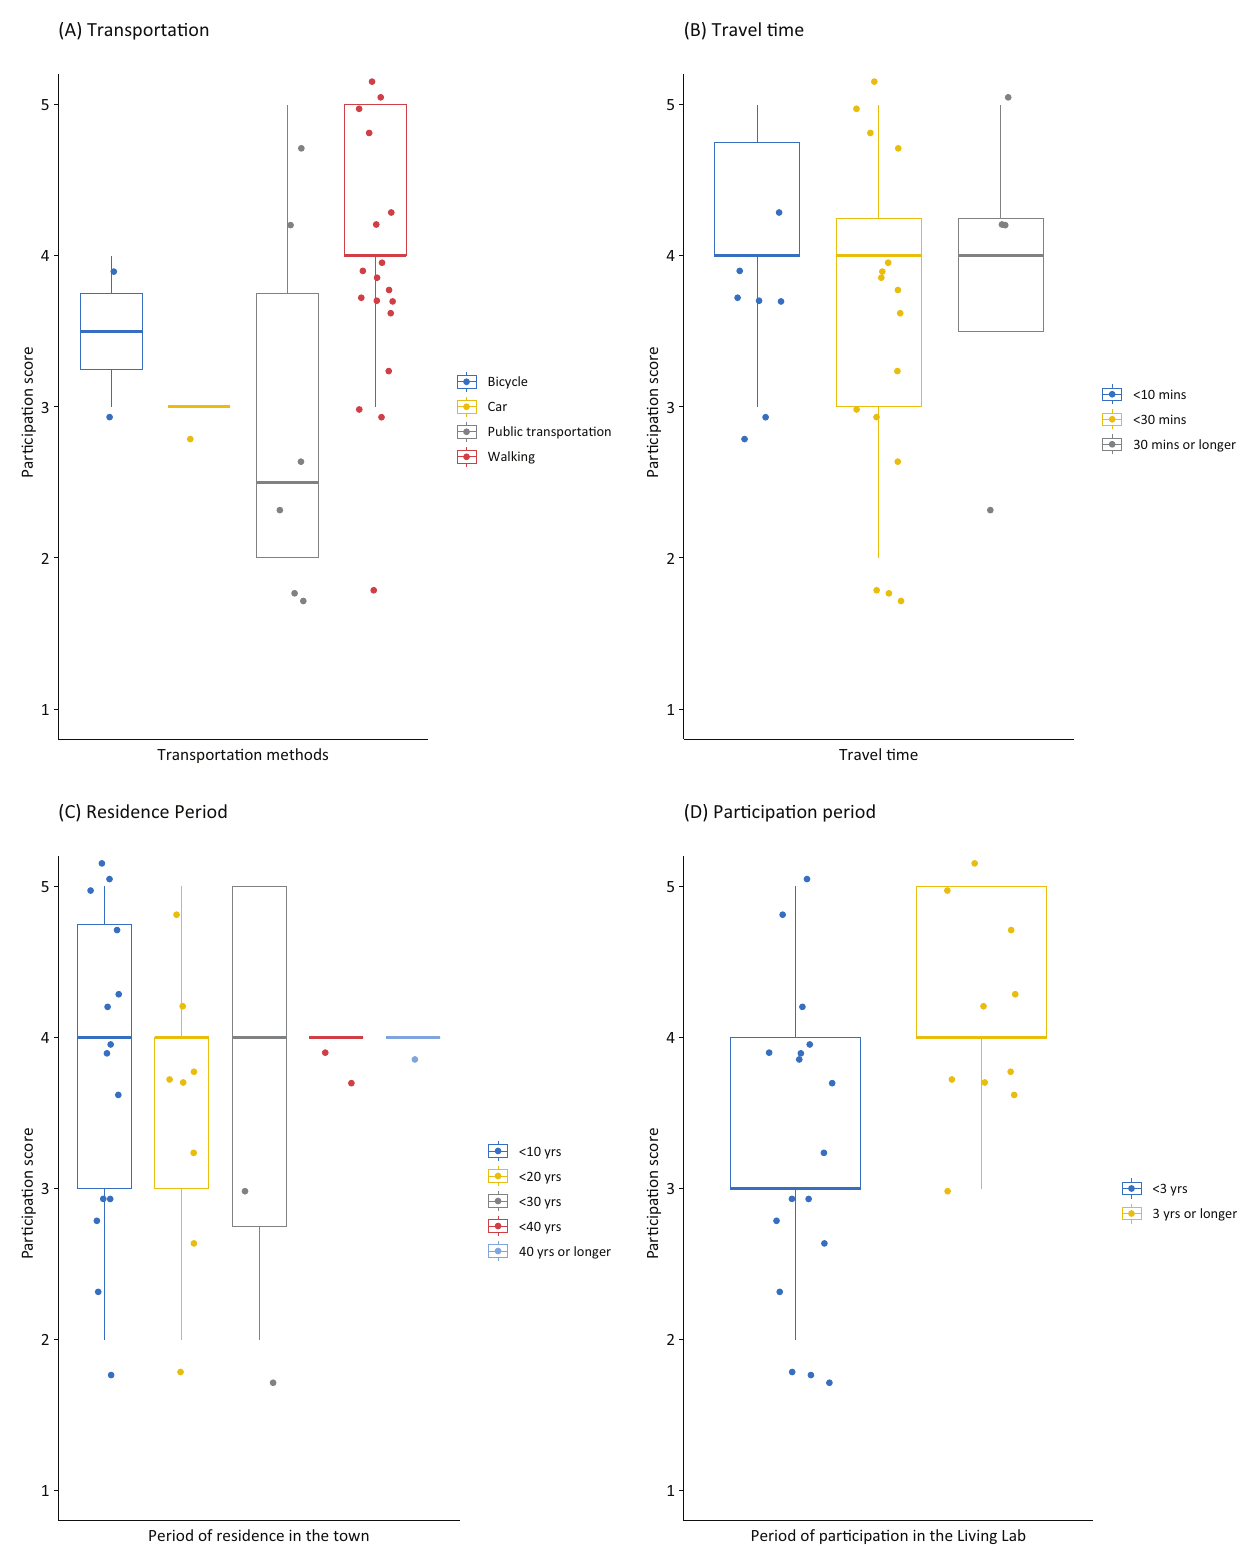
Figure 5. Participation scores by (a) transportation, (b) travel time, (c) residence period, and (d) participation